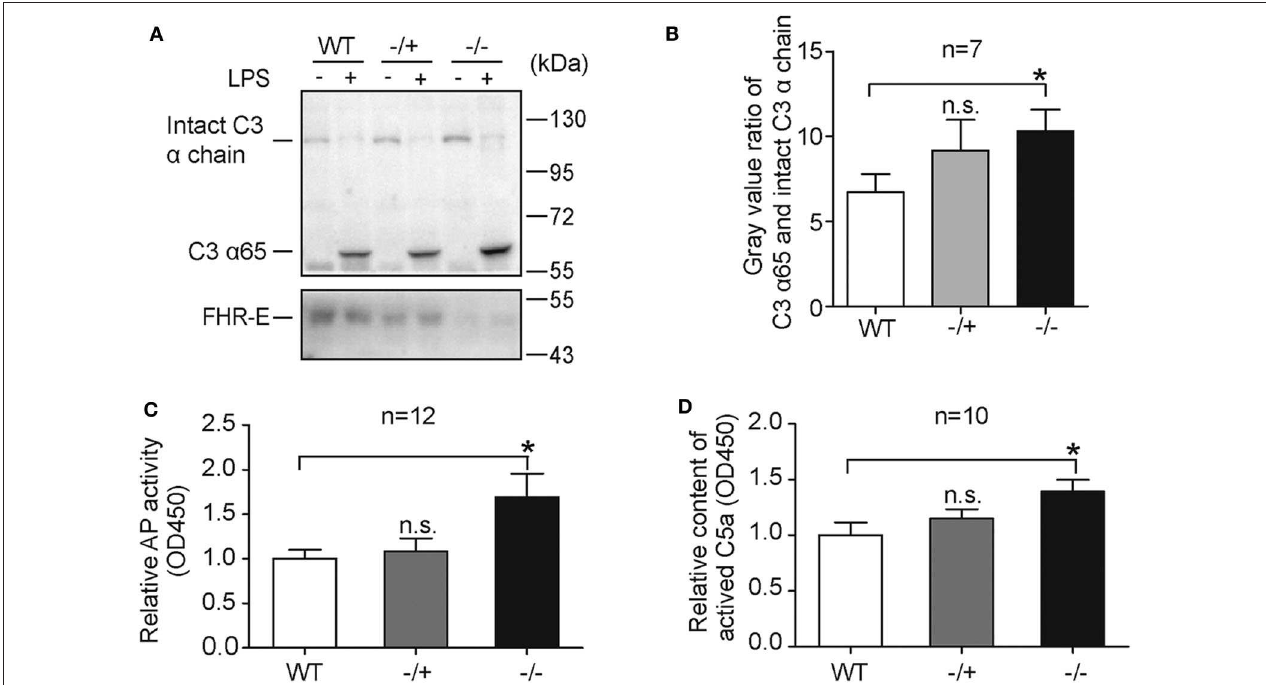
FIGURE 4 | Serological measurements of in vitro LPS stimulation. (A) Representative Western blotting analysis of C3 activation by LPS treatment among mice of different genotypes. Western blotting analysis of FHR-E was used for genotyping. Equal volumes of PBS were used as negative controls. Equal volume of protein was loaded. Seven mice in each group were used. (B) The gray values of C3 α 65 fragment and intact C3 α chain in (A) were measured with Image J. The gray value of C3 α 65 was divided by the gray value of intact C3 α chain in the same lane. The ratio of C3 α 65 and intact C3 α chain was used to represent cleavage status of C3 α chain. (C) Detection of AP activation by plate bounded LPS in diluted serum with ELISA method. Equivalent LPS was coated on the plate. AP buffer and EDTA buffer diluted serum was added into the plate and incubated for 1h at 37 ◦ C. EDTA buffer diluted serum was used as a negative control for background subtraction. After washing, the LPS-bound C3b was detected with C3 antibody. Twelve mice in each group were used. (D) Measurement of the concentration of C5a produced at 2h after LPS in vitro stimulation. AP buffer diluted serum was incubated with LPS or PBS for 2h at 37 ◦ C. Equal volume of PBS was used as a negative control for background subtraction. The quantity of C5a was detected with sandwich enzyme-linked immunosorbent assay. Ten pairs of mice were used. n.s., not significant. * p <